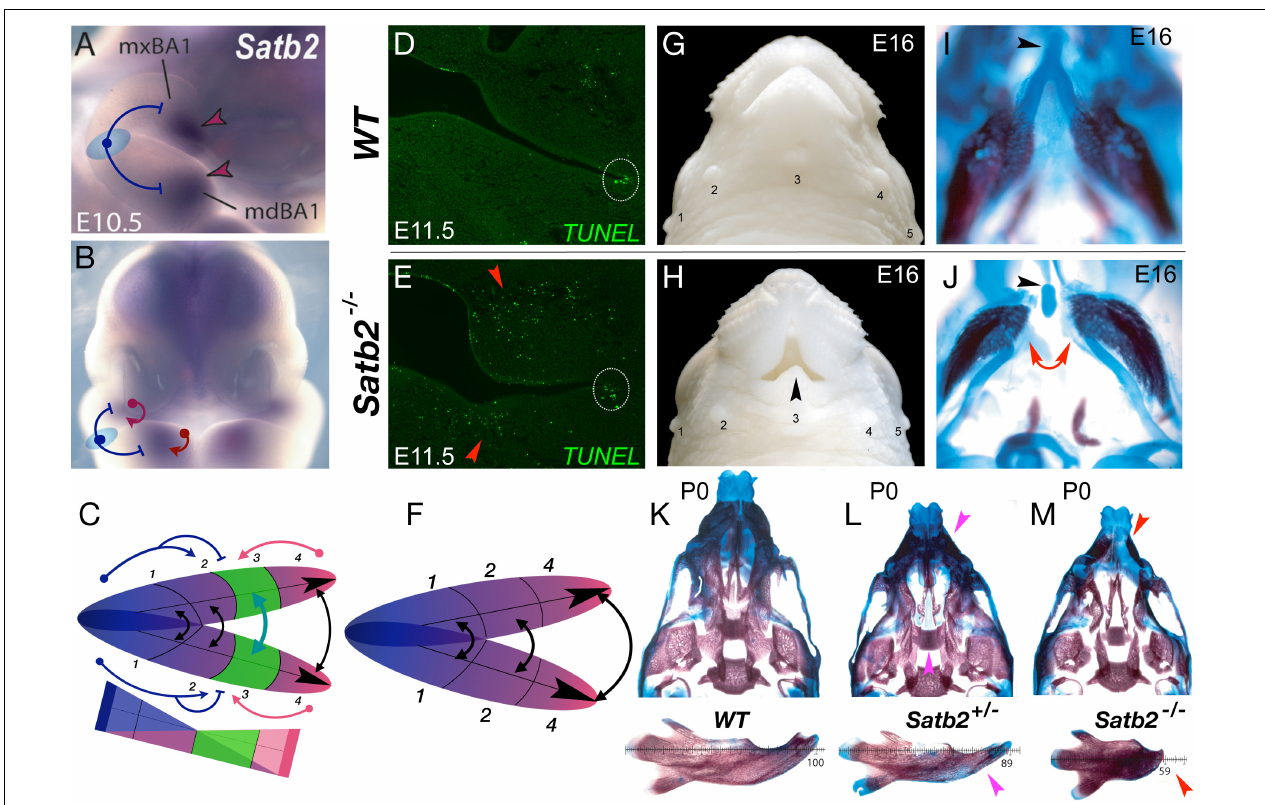
FIGURE 3 | Satb2 , apoptosis, and the elaboration of jaw modules. (A,B) Lateral (A) and frontal (B) aspects of E10.5 mouse embryos showing Satb2 expression in BA1 and the FNP. Blue T-bars suggest a plausible hinge-related repression of Satb2 and a red arrows a caps-related induction. (C) Schema depicting the coordinated nature of the Satb2- positive module (#3, in green). (D,E) Module restricted increase in apoptosis due to the loss of Satb2 . Frontal section of wild type (WT) and Satb2 null E11.5 embryos. Dotted white circle indicate the usual apoptosis at the oral commissure. (F) Schema of jaw development after the loss of the Satb2 -positive module. (G,H) Gross anatomy of the snout of wild type (WT) and Satb2 null embryos at E16. Black arrowhead indicates the maintenance of structure at the midline. 1–5, sinus follicles, noted for orientation. (I,J) Differential staining of bone (red) and cartilage (blue) of the samples in G and H. Red arrows indicate the drastic perisagittal loss of structure within Meckel’s cartilage of the Satb2 module. Black arrowheads indicate the rostral process of Meckel’s cartilage, a structure developed at the midline. (K–M) Differential skeletal staining of P0 wild type, Satb2 heterozygous and Satb2 homozygous neonatal crania (top) and dissected mandibles (bottom) demonstrating the conspicuous nature of gene dosage on the elaboration of development of the Satb2 module. Magenta arrowheads highlight deficiencies in Satb2 heterozygotes, while red arrowheads highlight the greater losses in the same structures in the Satb2 null